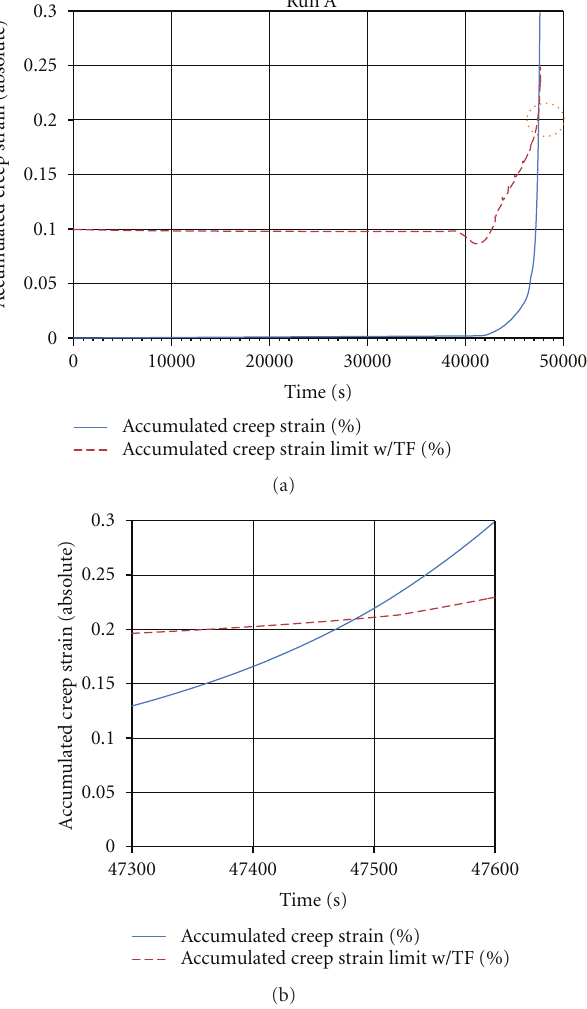
Figure 11: Accumulated creep strain and strain limit curve (failure at 47471 s): overview and detailed